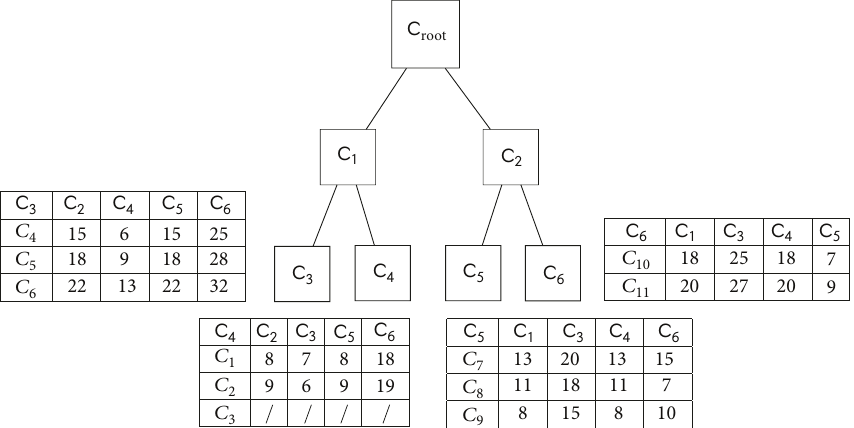
Figure 4: V-tree of the voronoi-based index in Figure